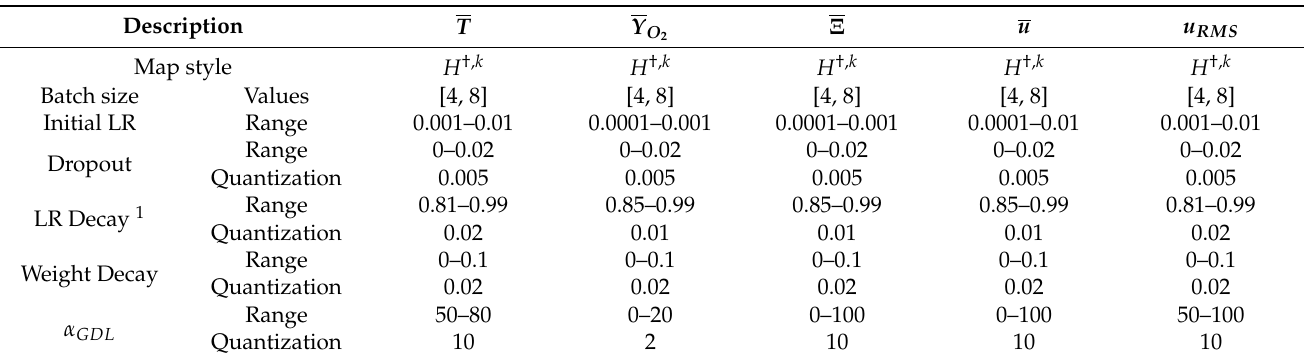
Table 4. List of hyperparameters we varied, their preset intervals, and quantization for each of the field quantities models provided. The map style has also been included to identify category of map elaborated by the resulting surrogate